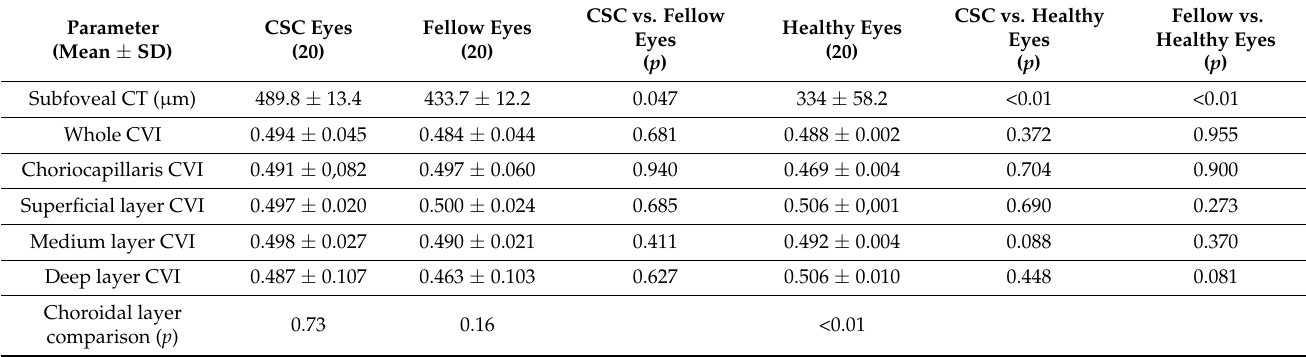
Table 1. Choroidal parameters in eyes with CSC, fellow and healthy